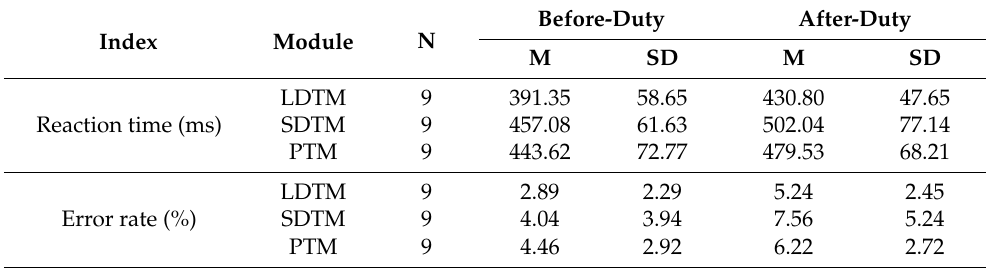
Table 6. The results of the measurements for PVTs.